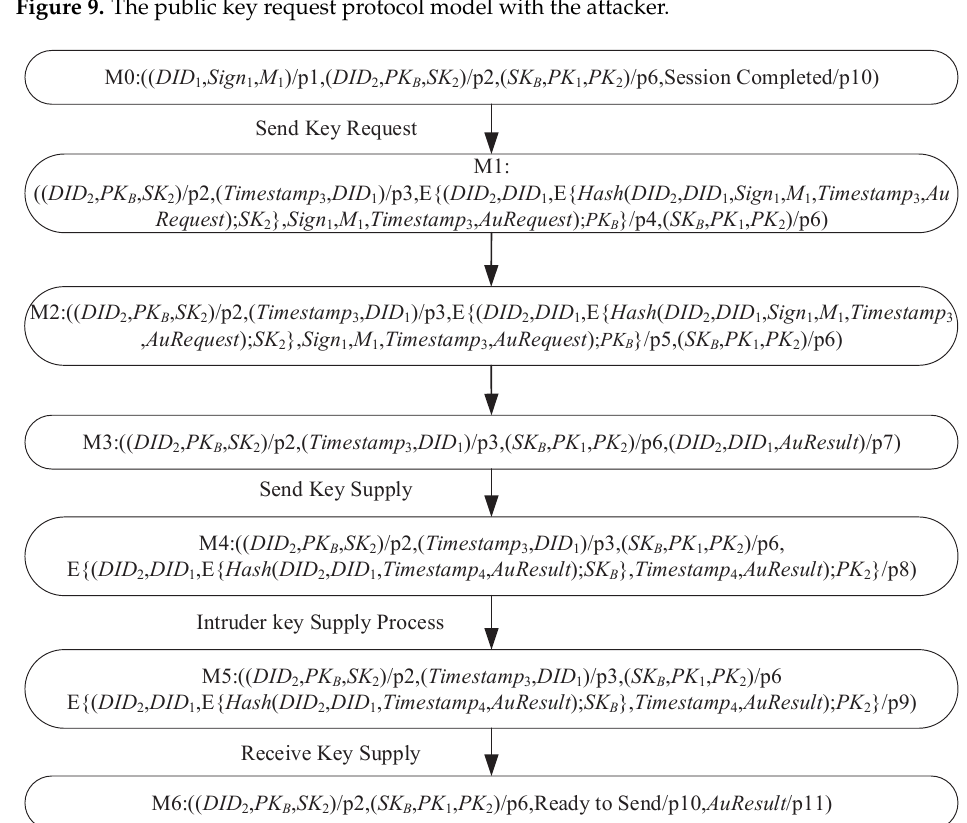
Figure 10. The reachable